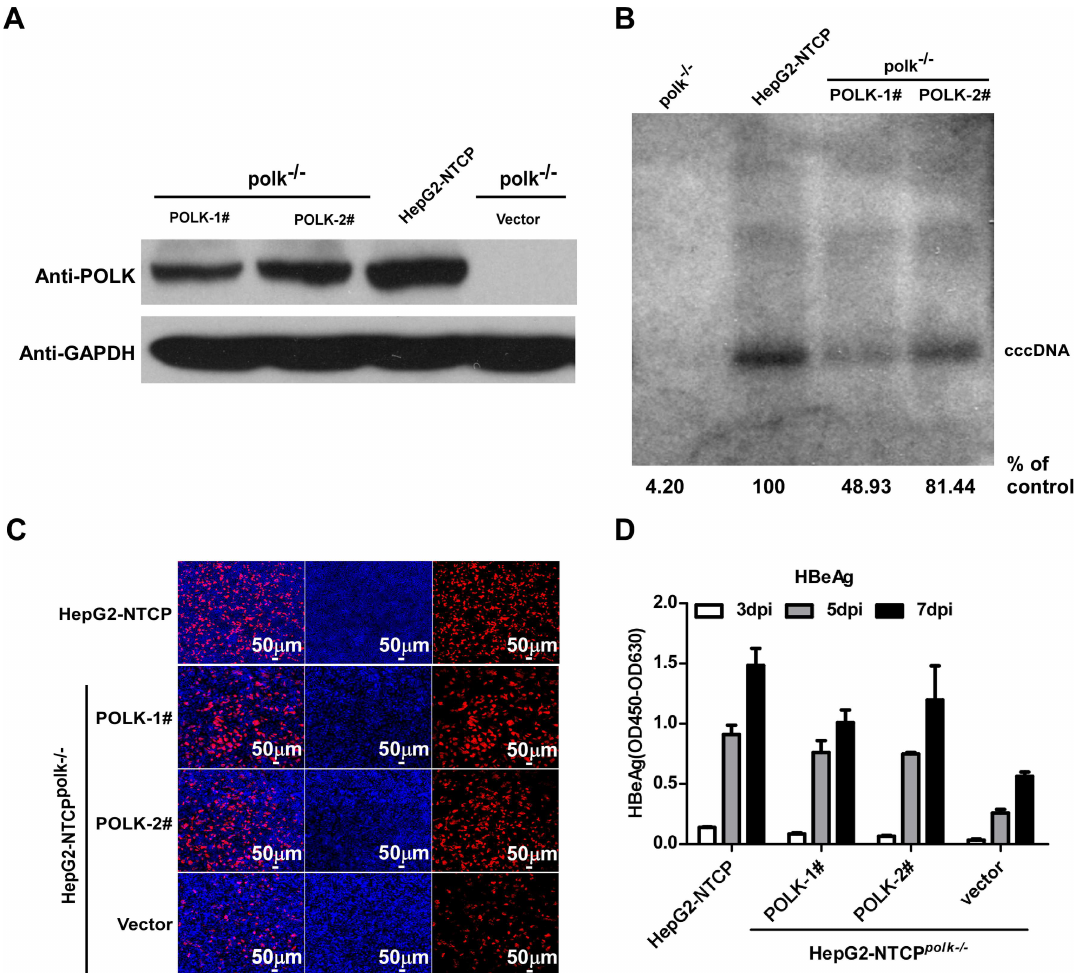
Fig 6. Ectopic expression of POLK rescues HBV infection in POLK deficient HepG2-NTCP cells. (A) Expressionof POLK in parental HepG2-NTCP and HepG2-NTCP polk-/- cells transduced with lentivirusexpressing wild-type POLK or empty vector were determinedby Western blot analysis. GAPDH served as a loadingcontrol. POLK-1# and POLK-2# are two clones expressingexogenousPOLK in HepG2-NTCP polk-/- cells. (B-D) Parental HepG2-NTCP and HepG2-NTCP polk-/- cells transduced with lentivirusexpressingwild-type POLK or empty vector were infected by HBV. HBV cccDNA in the infected cultures on 7 dpi were detected by Southernblot analysis. The intensity of HBV cccDNA bands were determined by Image J and the relative amounts of cccDNA were expressed as the percentage of that in the infected parental HepG2-NTCP cells (B). HBcAg in the infected cultures on 7 dpi was detected by immunostaining with 1C10 mcAb (red). Cell nuclei were stained with DAPI (blue) (C). Scale bars, 50 μ m. Secreted HBeAg from the infected cultures at 3, 5, 7 dpi were determined by ELISA